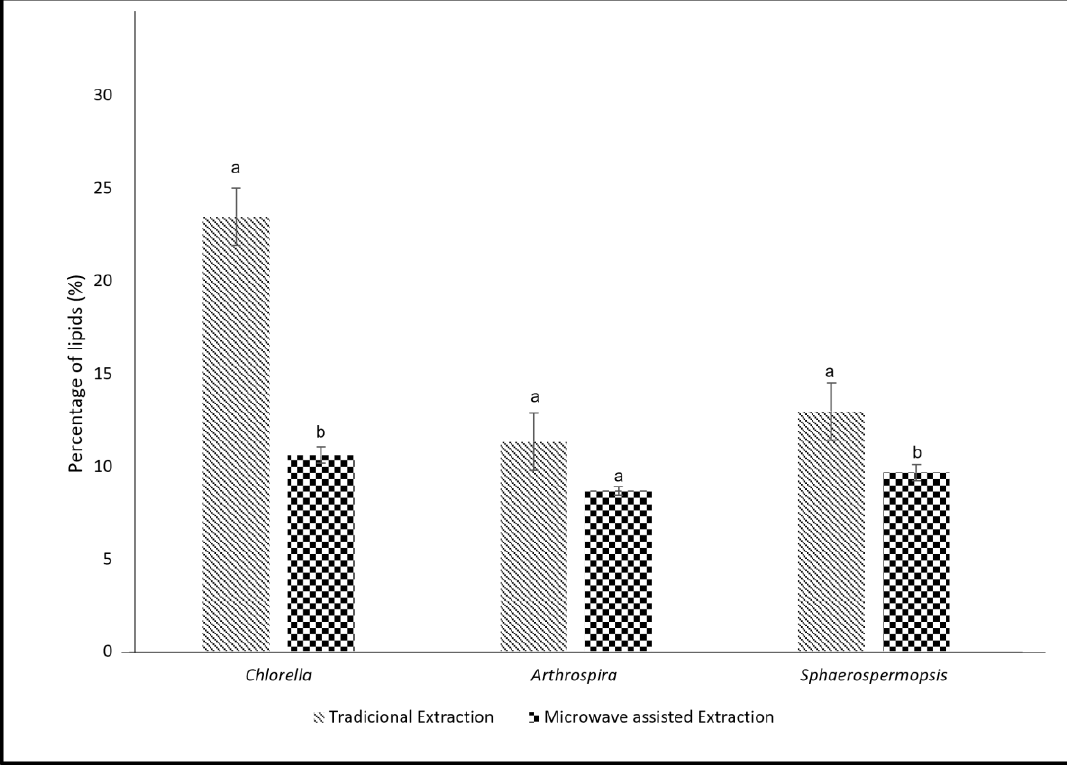
Figure 1. Comparison of lipid recovery yields from Chlorella sp., Arthrospira sp., and Sphaerospermopsis torques-reginae using traditional extraction and microwave-assisted extraction obtained by GC–MS (n = 3). Different letters indicate significant differences in the results ( p ≤ 0.05). Table 1. Average composition (% of area) of fatty acids obtained by traditional and microwave- assisted extractions of cyanobacterial and microalgal biomass (n = 3). Arthrospira sp. Chlorella sp. S.